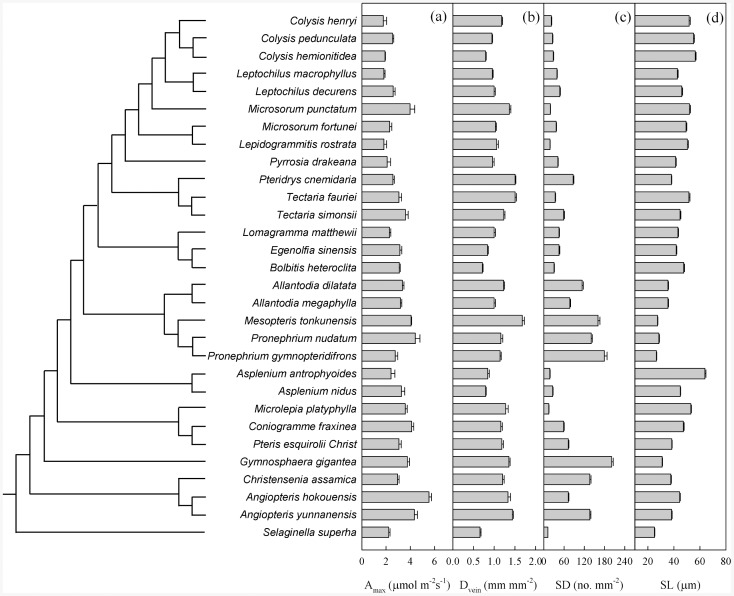
Phylogeny with labeled nodes used for comparative analysis of trait variation among 30 fern species along with trait values (mean ± 1 SE) for maximum photosynthetic rate (Amax; a), vein density (Dvein; b), stomatal density (SD; c), and stomatal length (SL; d).